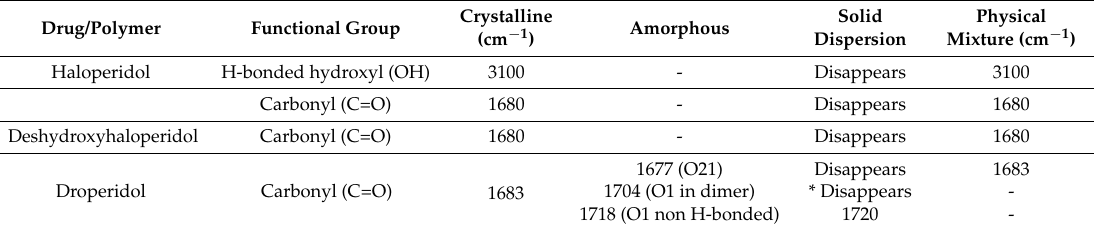
Table 3. Summary of infrared spectral peaks for HP, DP, DHP- PVPK30 binary systems studied.